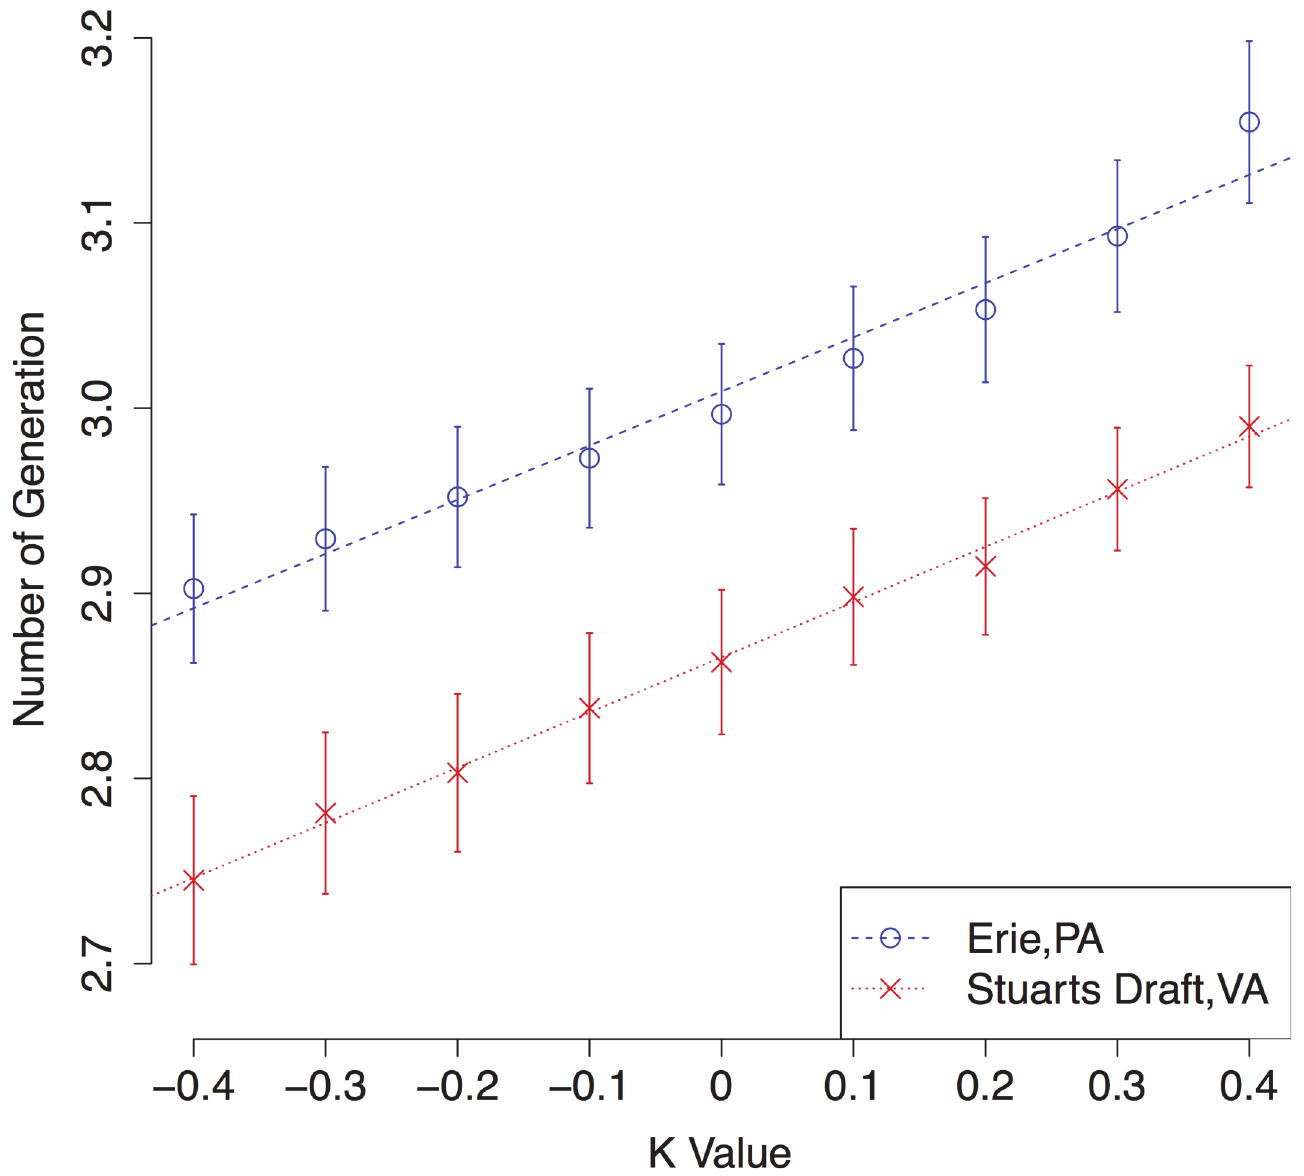
Fig 3. Number of Generations of P . viteana under Same Mean with Various DTR Change Conditions. Note: The dots represnet mean number of generations (voltinism) with error bars represent standard errors. The lines represent linear regression of voltinism against k values for both locations. The slopes of both regression lines are highly significant ( p < 0.01), indicating a strong increasing trend of voltinism with larger